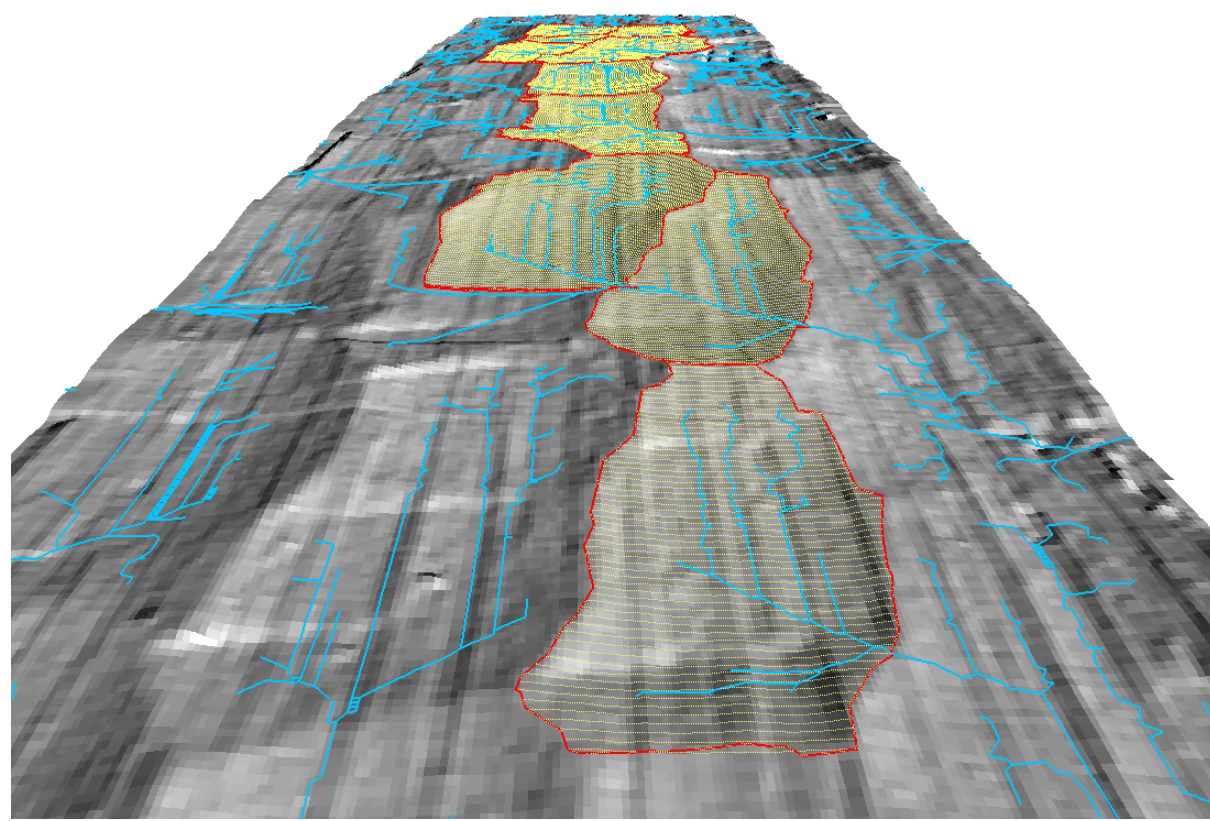
Figure 7. Hand Tool Nr.2 – Visualisation of the selected tool marks in 3D GIS environment - blue lines: calculated stream network; red lines: the facets, the boundaries of the predefined polygons; yellow lines: the extracted